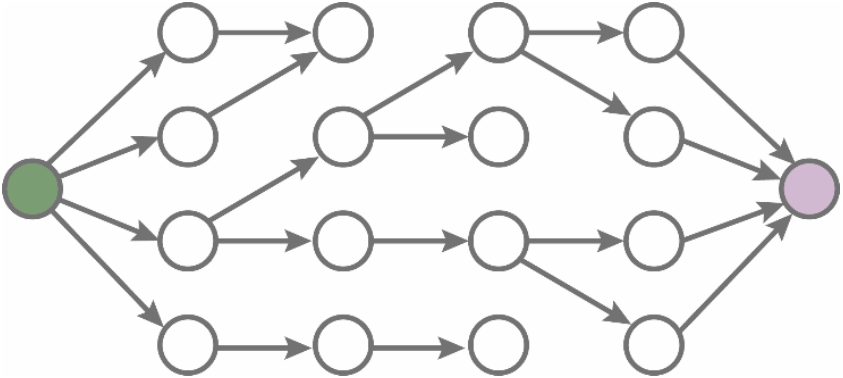
Figure 3. An example of DAG of depth 4, width 4.